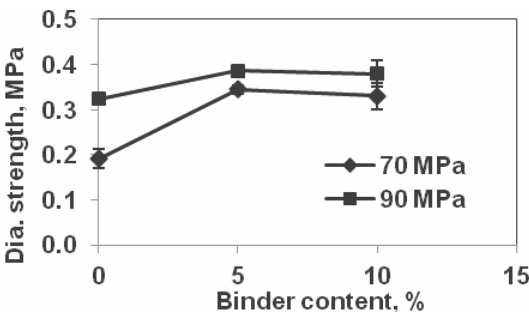
Fig. 3 Axial penetration strength of tablets.